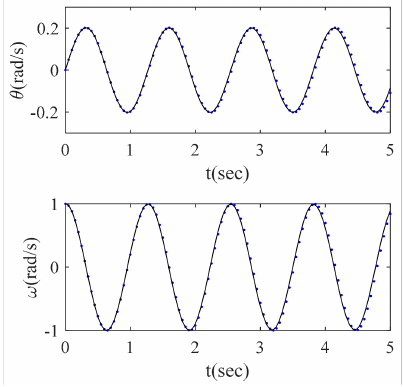
Figure 6. The comparison of the first 5 s.